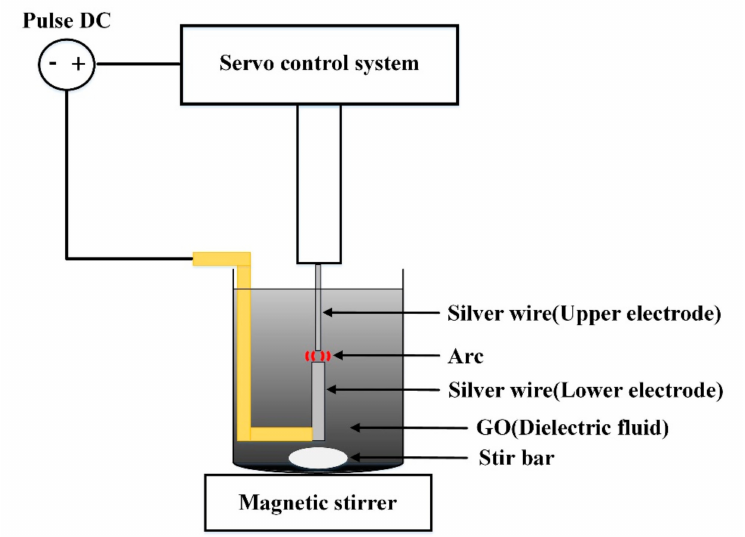
Figure 1. Schematic of rGOAg preparation.